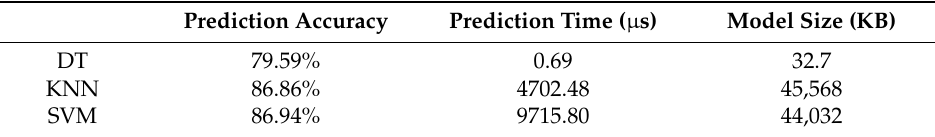
Table 3. General accuracy of each algorithm with the proposed 14